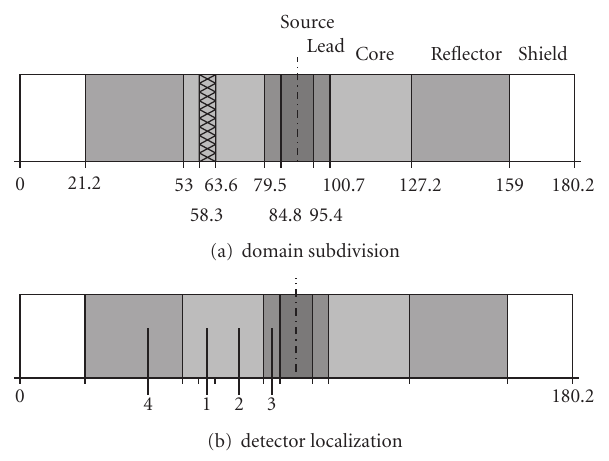
Figure 10: System domain adopted for the three-group calcula- tions. The localization of the region where the cross section per- turbations are introduced is highlighted (a), as well as the position of the four detectors